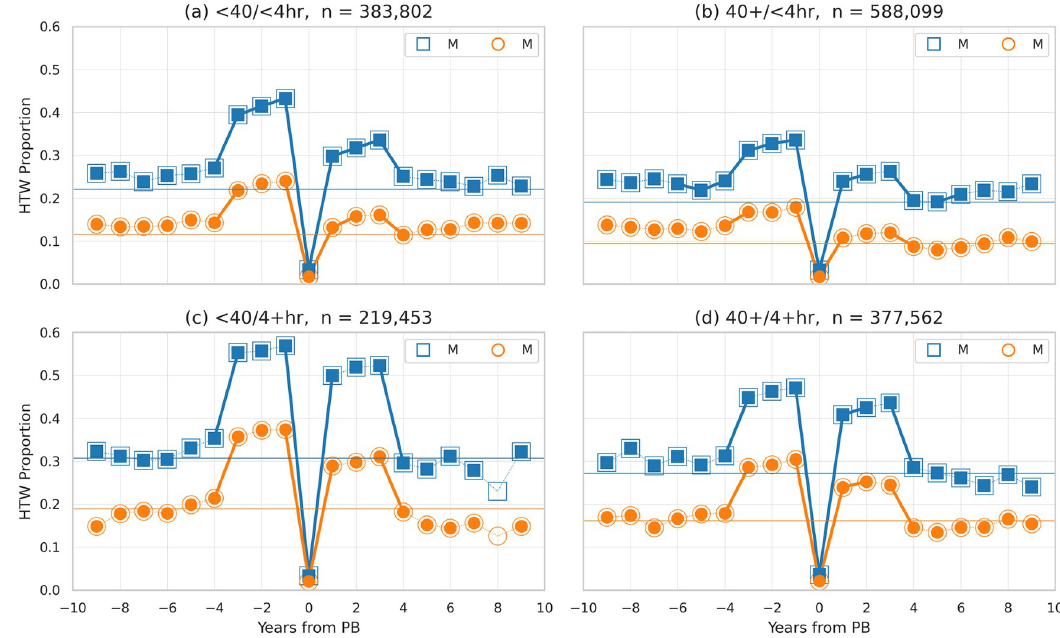
Fig 4. The proportion of male and female runners hitting the wall based on the number of years before ( < 0) and after ( > 0) their overall (estimated) PB, and based on age and ability.